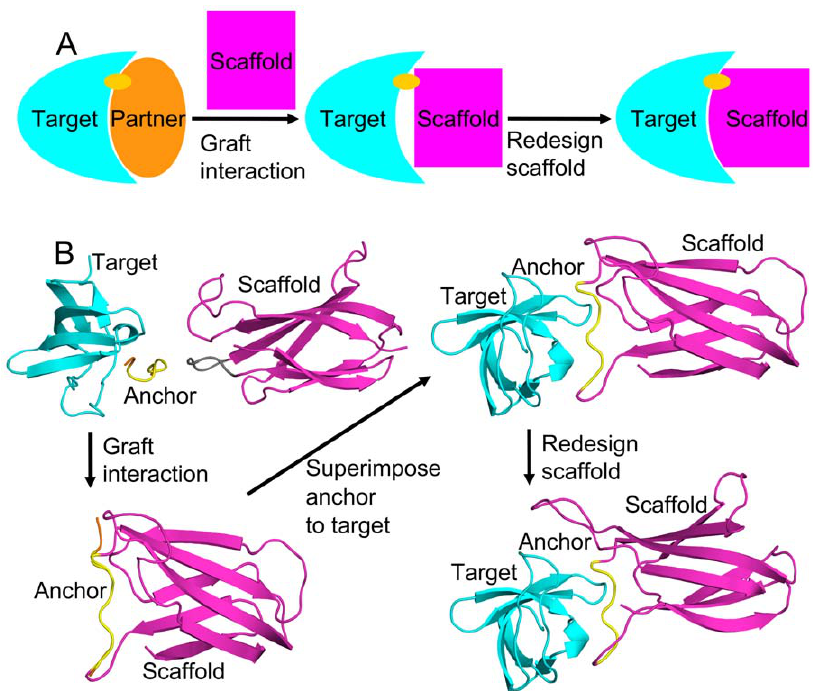
Figure 1. Anchor insertion. Panel A demonstrates the AnchoredDesign process with a simple cartoon. At left, we start with a known interaction between a target (cyan) and a natural partner (orange) with a characteristic interaction (the anchor, yellow). In the middle, we graft the anchor into the scaffold (magenta) to create a rough starting structure. At right, we fill out the scaffold-target interface with the AnchoredDesign protocol. Panel B demonstrates the process using protein structures for greater clarity (using the same color scheme).